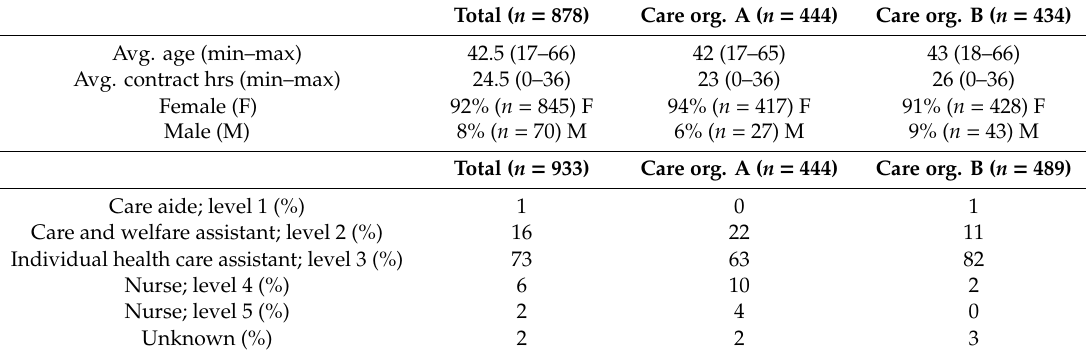
Table 2. Characteristics of device